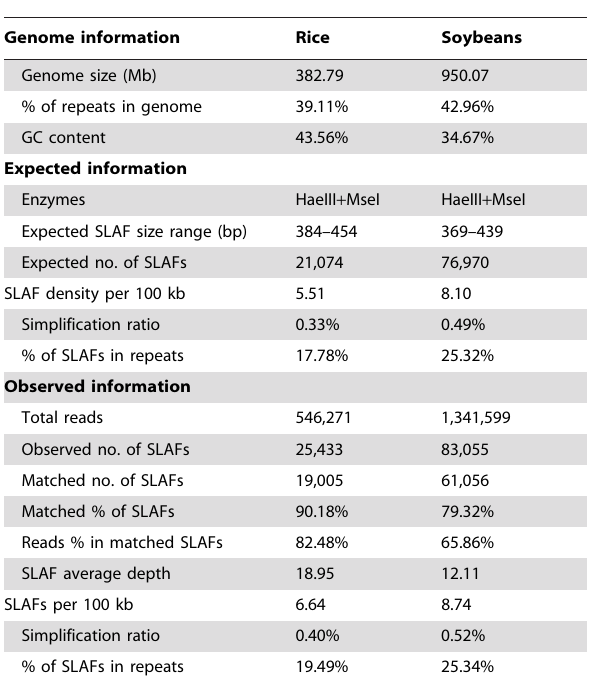
Table 2. SLAF-seq data summary for common carp F1